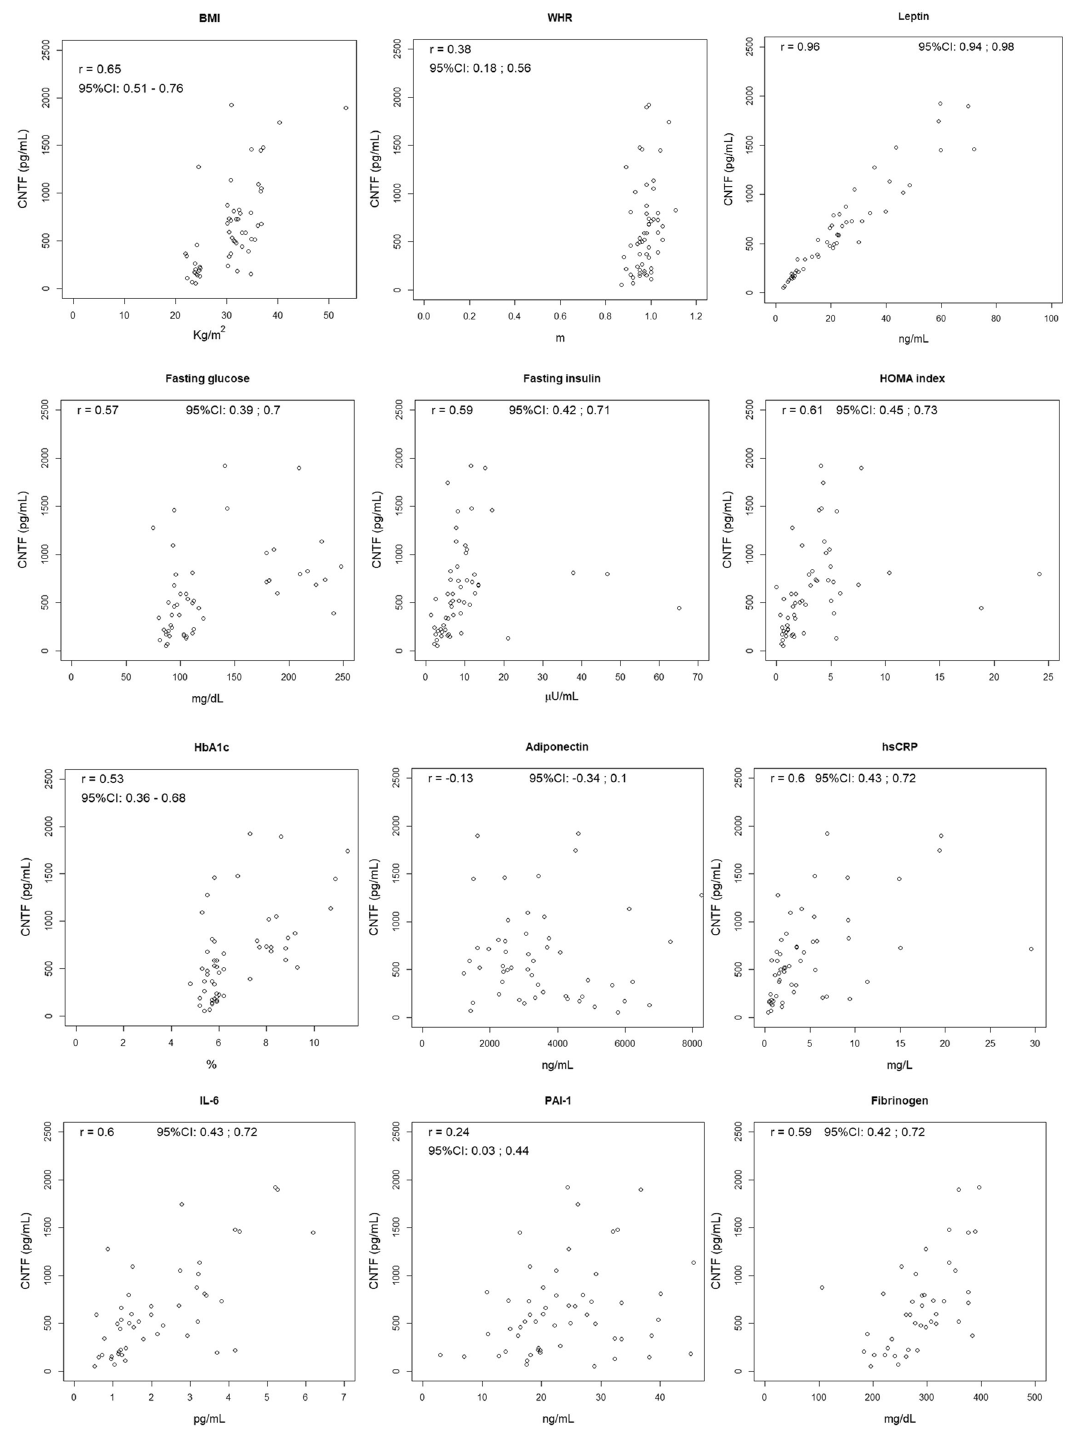
Figure 3. Correlation between plasma CNTF levels and clinical or haematological parameters of obesity, insulin resistance and inflammation in male subjects. Spearman correlation coefficients and 95%